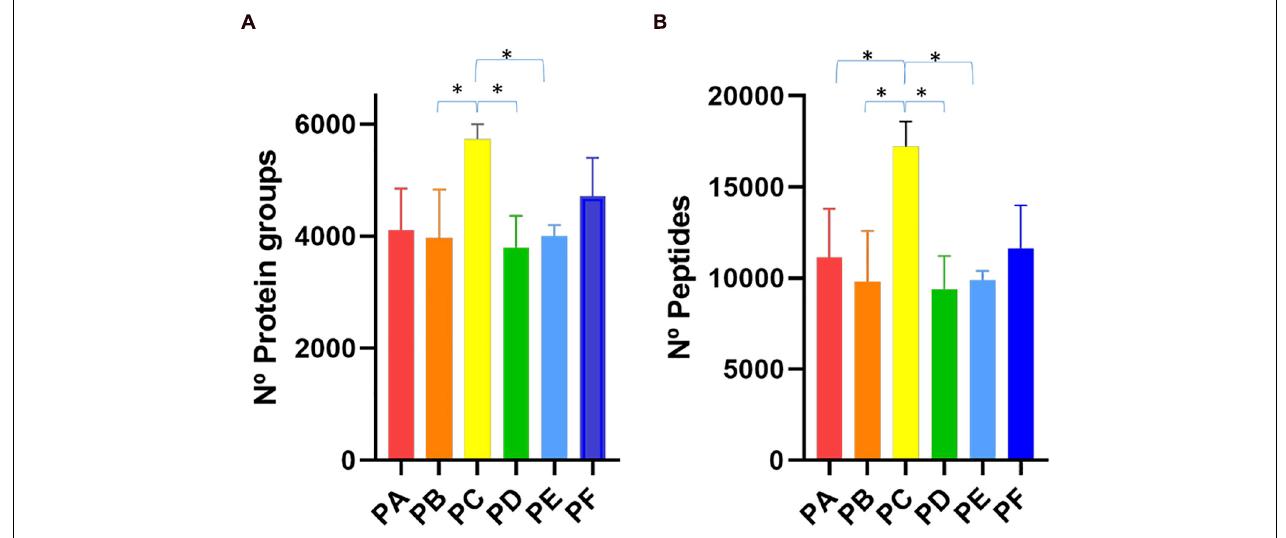
FIGURE 2 | Bar plot representing the number of (A) protein groups and (B) peptides identifications achieved with the six different protocols tested (PA–PF). ∗ p <